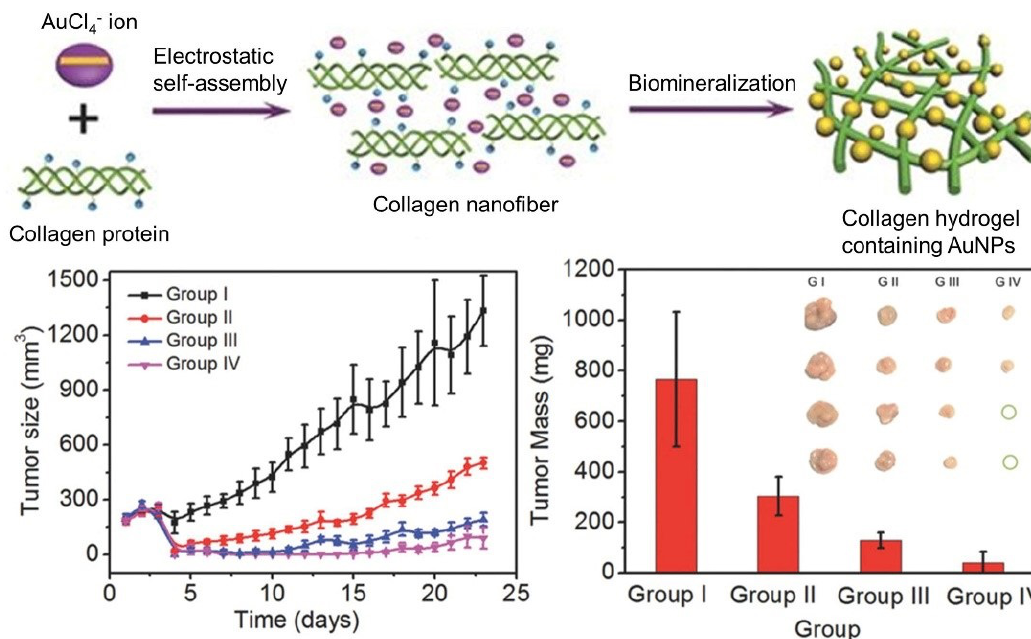
Figure 5. Schematic representation of the formation process of injectable AuNPs-collagen nanocomposite hydrogel via electrostatic self-assembly and biomineralization. Tumor volumes and weights after different treatments demonstrated the synergistic therapy efficacy of PTT/PDT against MCF-7 tumors. Adapted with permission from Ref.